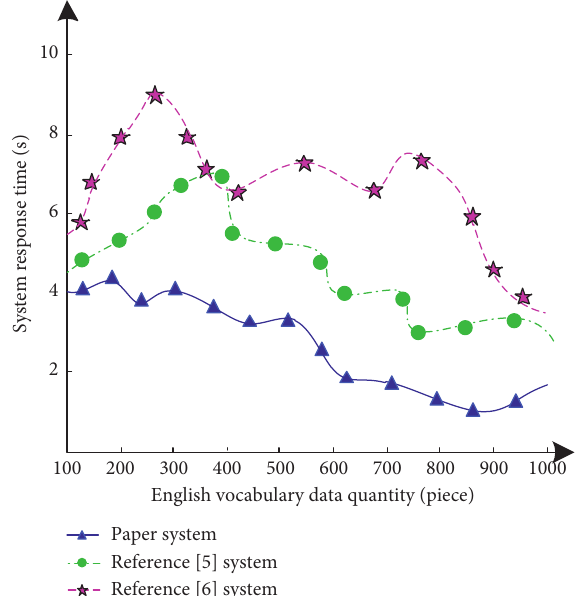
Figure 5: Comparison of response time-consuming results of different systems.